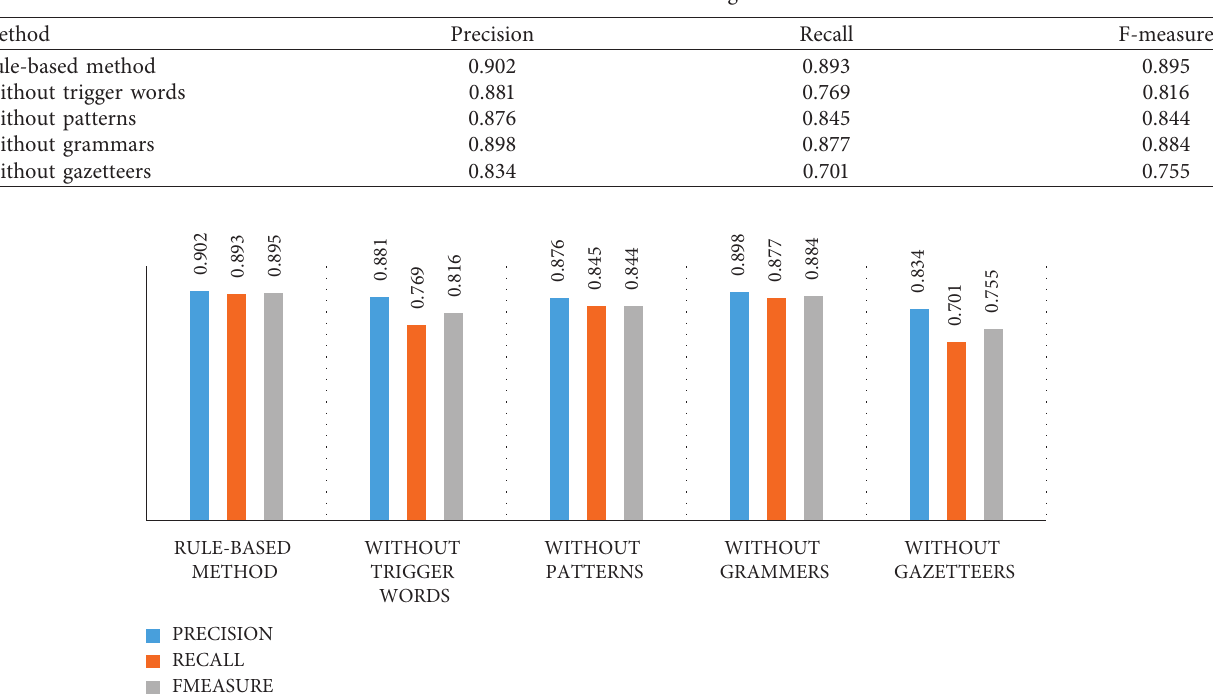
Figure 11: The overall results. Table 17: The overall results of integration.